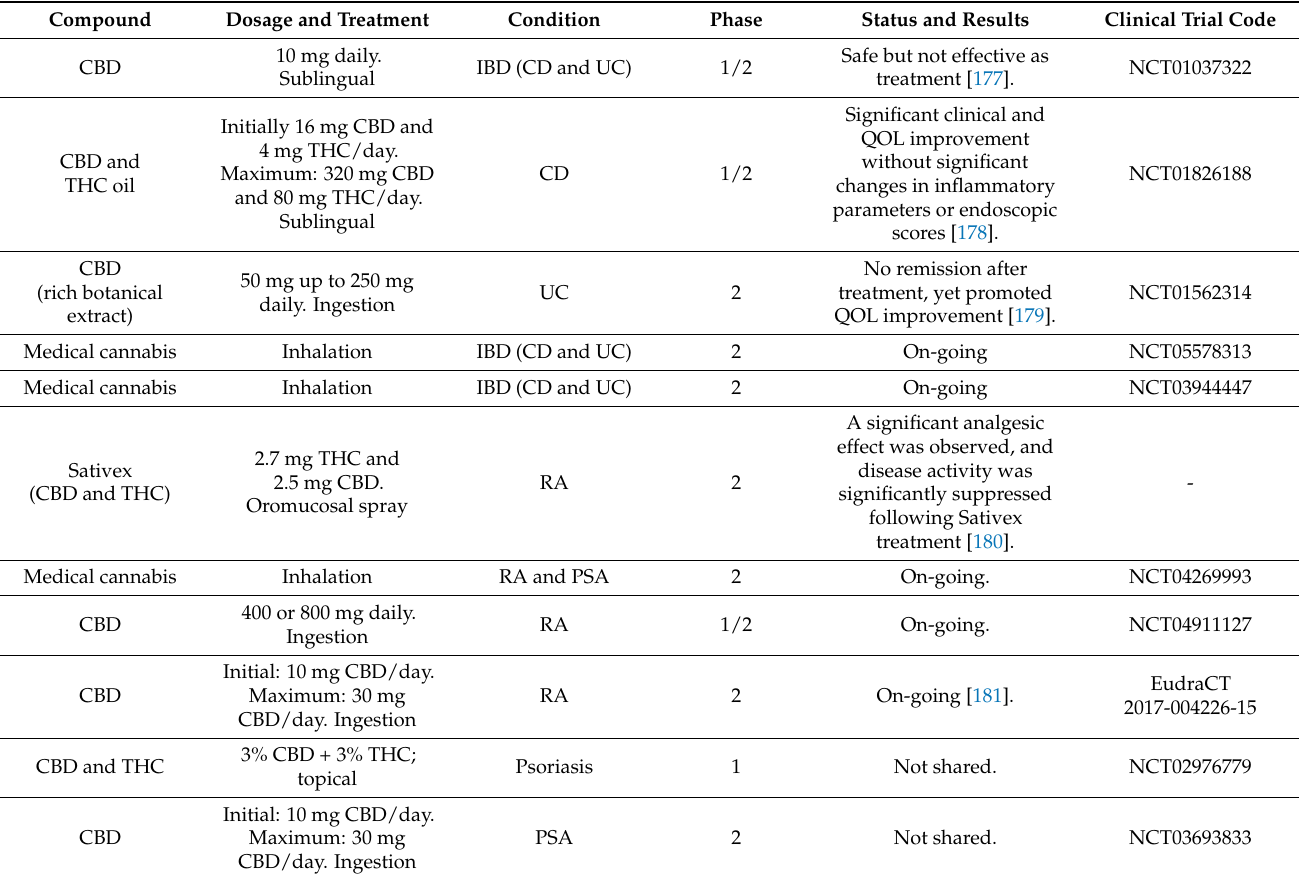
Table 3. List of clinical trials available for the use of CBD in autoimmune